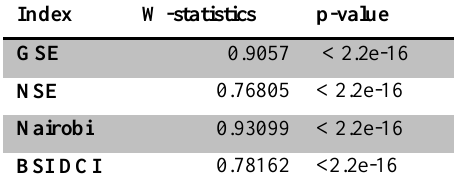
Table 2: Result of the Shapiro-Wilks Test